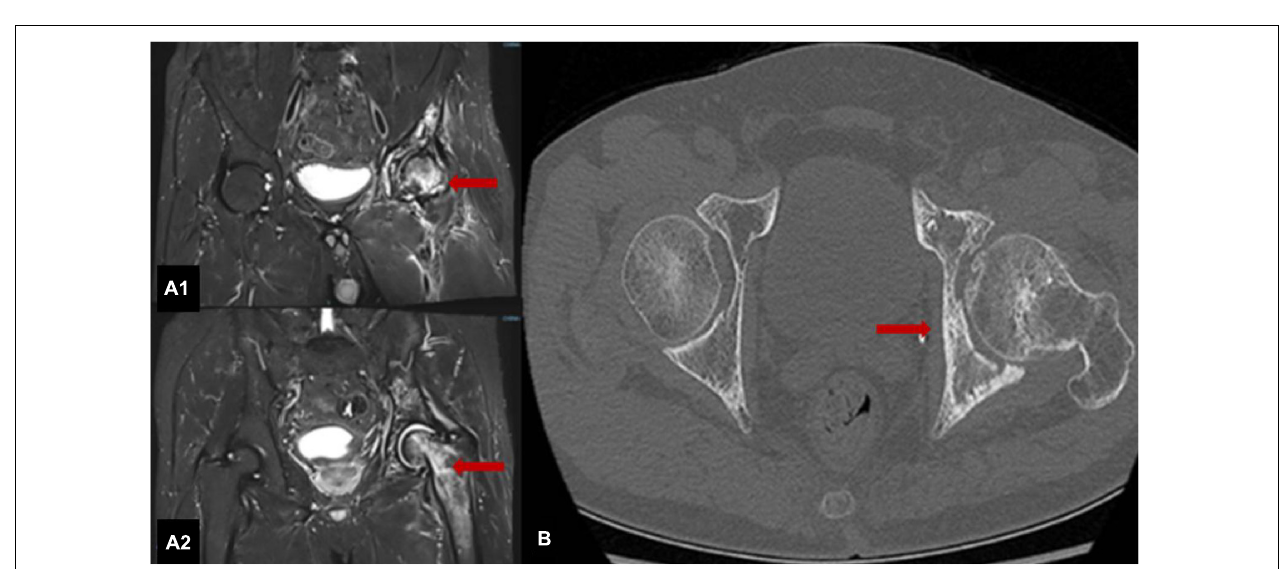
FIGURE 1 | The morphology of the acetabulum and femoral head is bilaterally normal, with uniform internal signals (A1,A2) ; when underwent 3 months of radiotherapy, femoral head with slightly longer T1 and T2 signals, and uneven and patchy internal signals (B) . Bilateral hip joint space narrowing is seen on X-ray examination, and the articular surface is less smooth. The femoral heads on both sides have become flattened and show uneven density (C) . Post-operative examination an artificial hip replacement is seen on the left hip, which is in a normal position (D) . Two and a half years after surgery, the prosthesis is in normal position (E) .